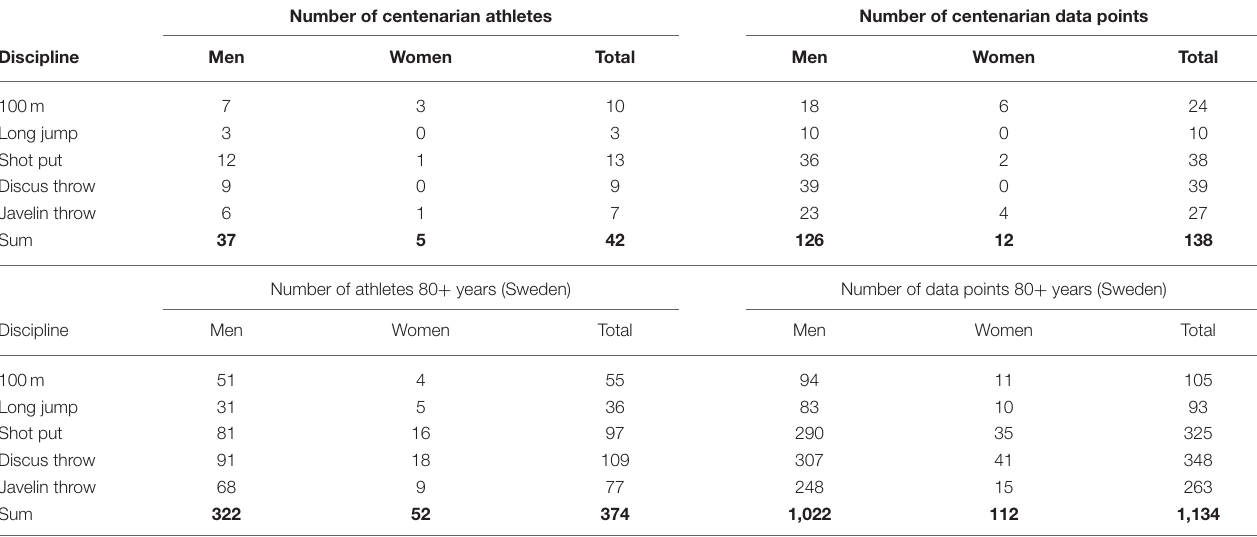
TABLE 1 | Numbers of athletes and data points per discipline in the present centenarian (100 + -years group) and Swedish (80 + group) data sets, separated by sex. Number of centenarian